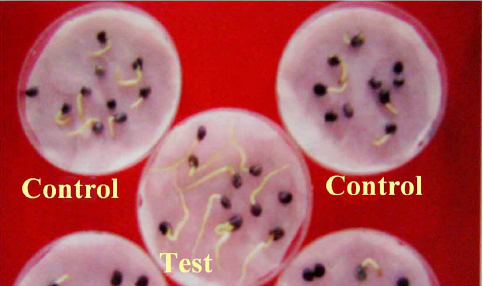
Fig. 2 . Germination of Bacillus thuringiensis A5- BRSC treated Abelmoschus esculentus seeds (test) in comparison to un-treated seeds